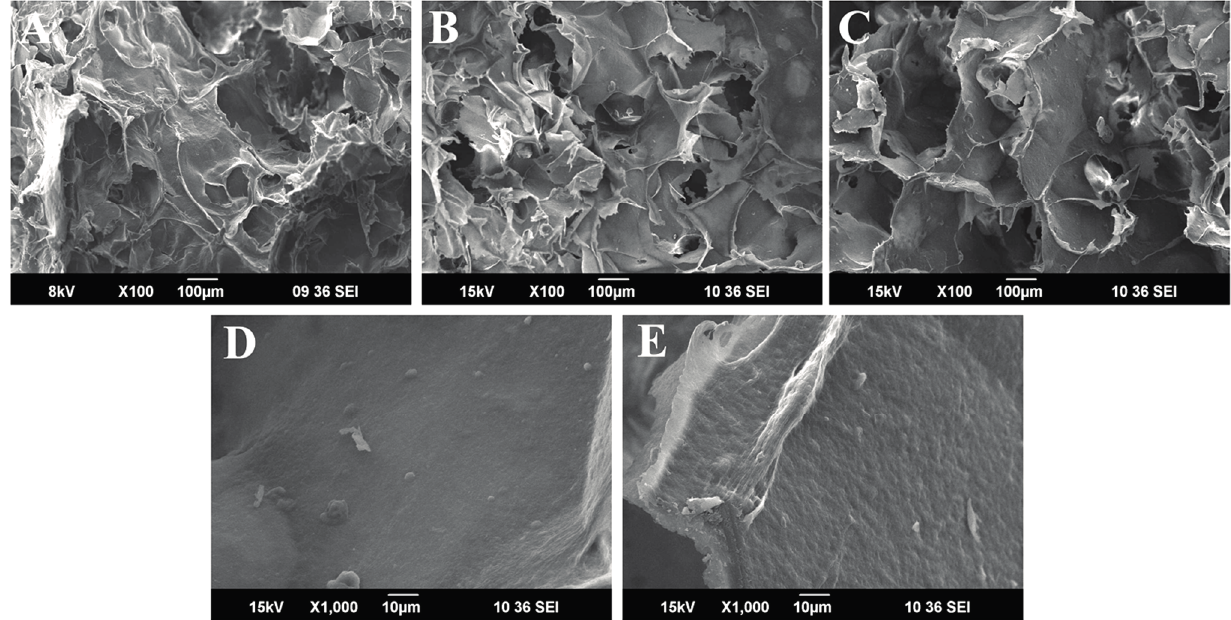
Figure 3. SEM image of ( A ) chitin, ( B , D ) chitin/PBS, and ( C , E ) Chitin/PBS/CSnps.